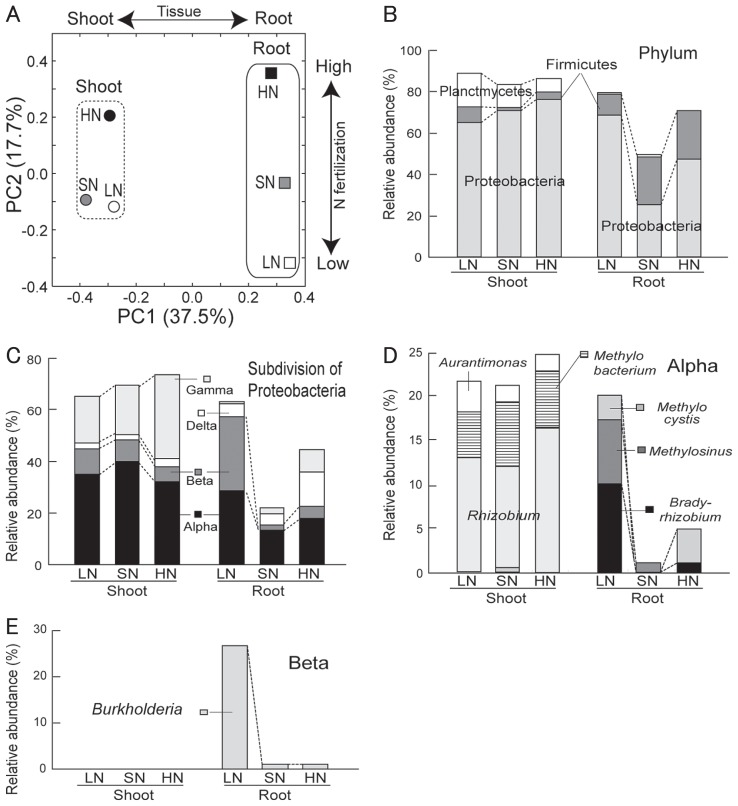
Principal coordinate analysis (PCoA) and phylogenetic compositions of 16S ribosomal RNA gene clone libraries of rice shoot- and root-associated bacterial communities under low (LN), standard (SN), and high (HN) N fertilization. Panel A, PCoA ordination was constructed using Unifrac distances. (B–E) Relative abundances of the phyla (B), subdivision of Proteobacteria (C), and the major genera of Alphaproteobacteria (D) and Betaproteobacteria (E). Alpha, Beta, Gamma, and Delta indicate Alpha-, Beta-, Gamma-, and Delta-proteobacteria, respectively.